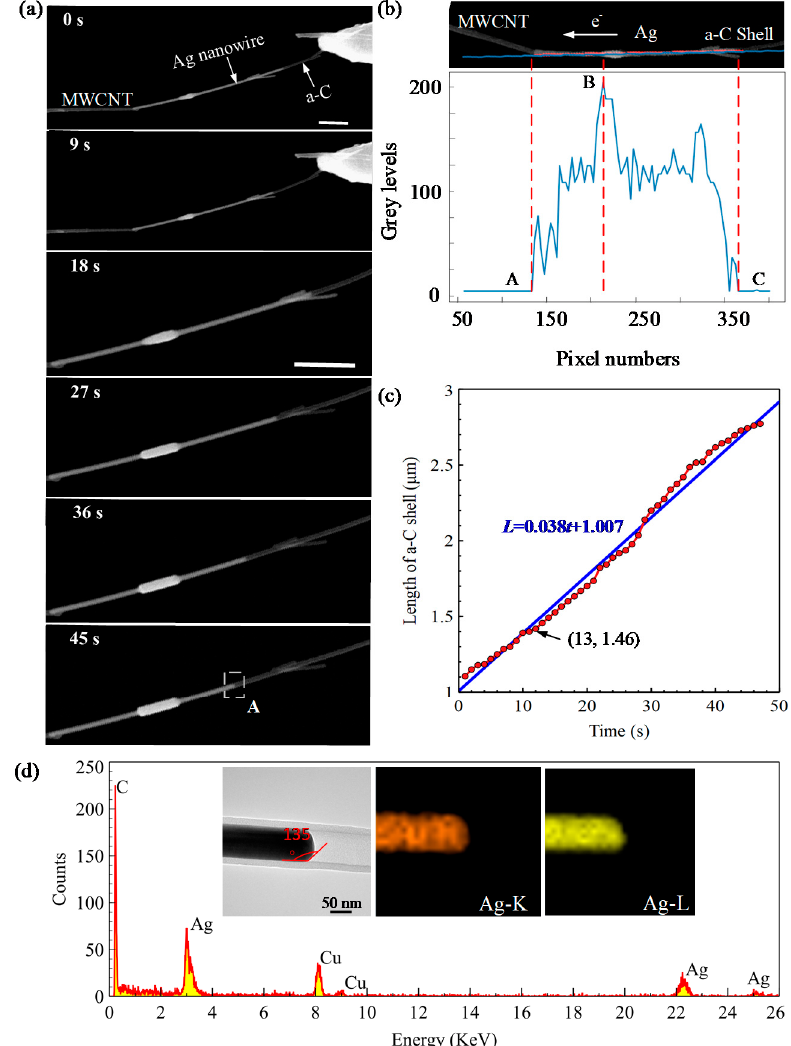
Figure 3. The controllable flow of the encapsulated Ag and elemental characterization of the transparent shell from PVP pyrolysis. ( a ) Time-resolved flow of the wrapped Ag. Scale bar: 1 µm; ( b ) Transfer velocity extraction of the molten Ag based on image processing; ( c ) Time-resolved mass transport velocity of the molten Ag; ( d ) Morphology and constituent elements study of the newly formed core–shell nanostructure. The inset images demonstrate the typical TEM image of the a-C shell and its constituent elements. The EDS mapping area (400 nm × 400 nm) is highlighted in ( a ) at 45 s by a white dotted